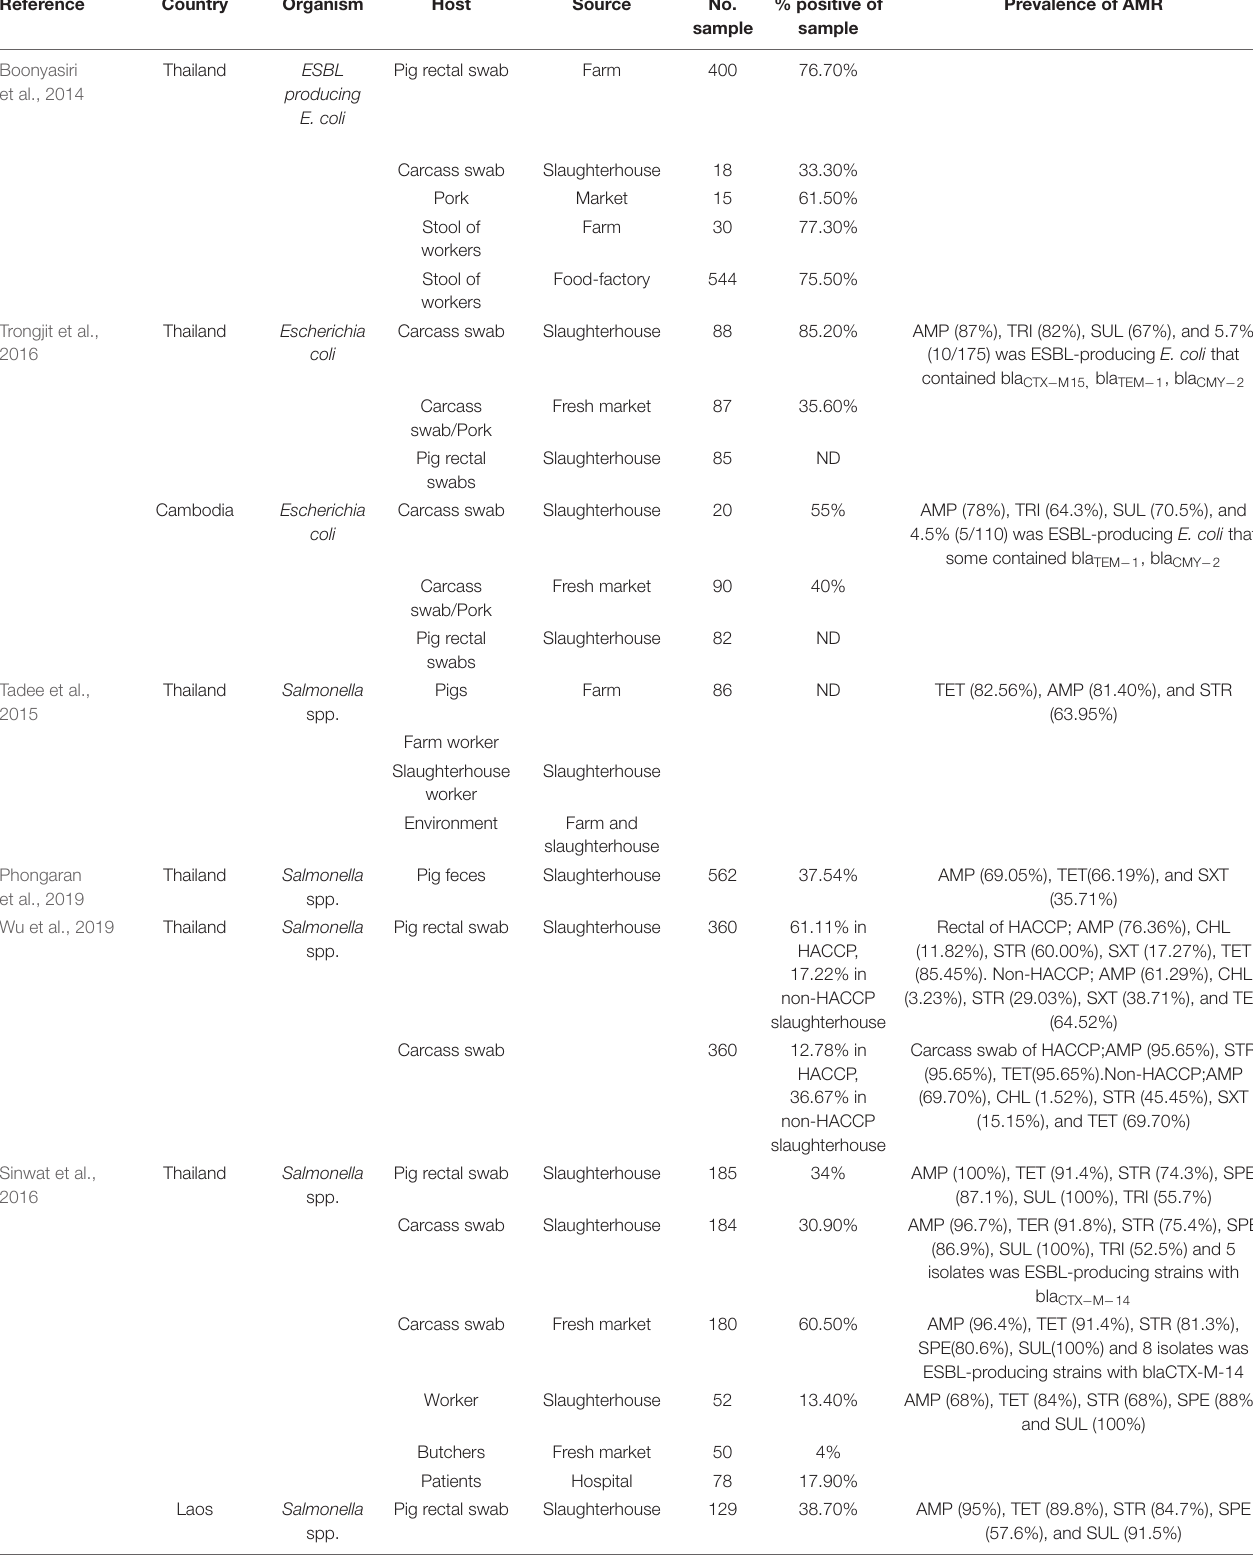
TABLE 4 | Phenotypic AMR in organisms isolated from difference